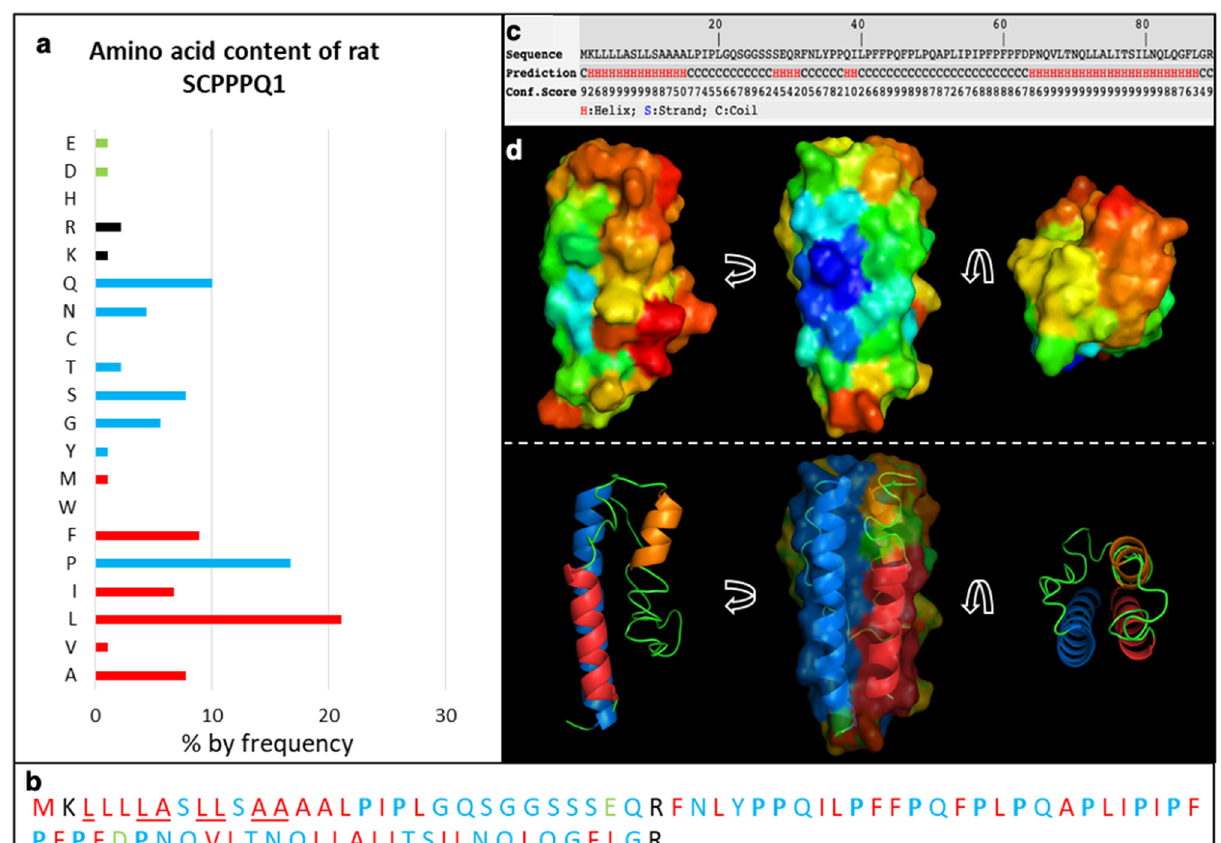
Figure 1. In silico analysis of the rat SCPPPQ1 sequence. ( a ) Analysis of the amino acid content reveals the high hydrophobicity of the protein (40%) and a total net charge of + 1. (red = hydrophobic amino acids; black = positively charged amino acids; green = negatively charged amino acids; blue = other amino acids) (APD3 22 , http://aps.unmc.edu/AP/). ( b ) SCPPPQ1 possesses a sequence rich in proline residues (highlighted in blue and bold). The hydrophobic residues believed to be on a same 3D surface are underlined. ( c ) iTASSER 23 (https ://zhang lab.ccmb.med.umich .edu/I-TASSE R/) analysis predicts the position of helices on SCPPPQ1. ( d ) The Quark 24 (https ://zhang lab.ccmb.med.umich .edu/QUARK /) model further predicts that the red ⍺ -helix corresponds to signal peptide (residues 2 to 15), the orange ⍺ -helix to residues 28 to 32, and the blue ⍺ -helix to residues 64 to 87, which is consistent with the iTASSER